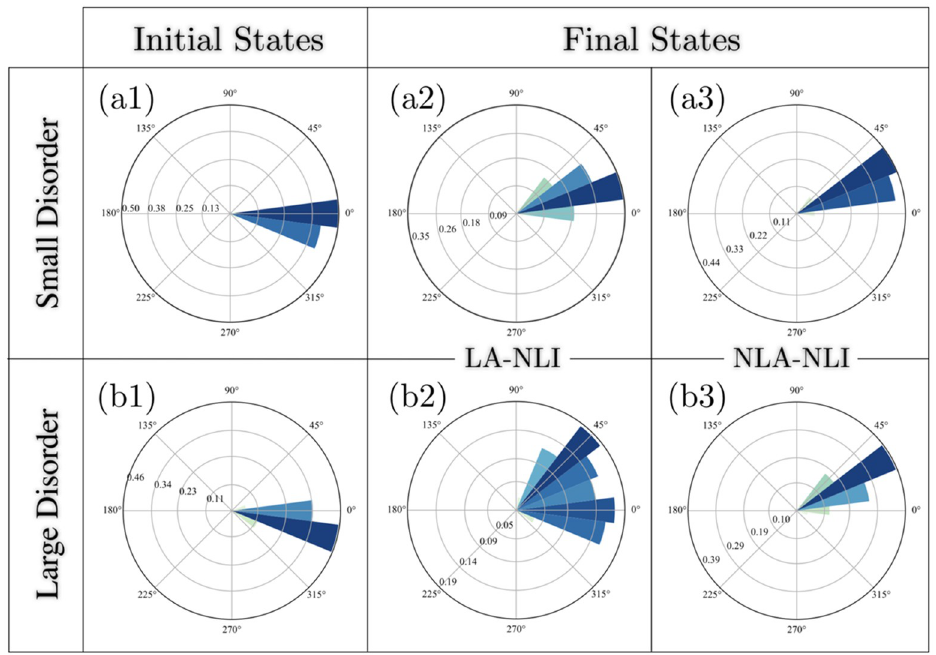
Fig 4. Comparison of the polarization stability in systems with local and nonlocal upregulating interactions, but identical cellular geometries and initial conditions (for each value of the geometric disorder). The magnitude of stochastic noise equals η 0 = 0.1 in all cases. (a1) illustrates a polarized initial condition in a tissue with small geometric disorder � 0 = 0.45. (a2) and (a3) show the steady-state angular distributions of dipoles in the same tissue with LA-NLI and NLA-NLI mechanisms, respectively. The same quantities are depicted in (b1), (b2) and (b3), but in tissue with large geometric disorder � 0 = 0.6. Loss of angular coherence in (b3), indicates that the absence of nonlocal upregulating interactions makes polarity susceptible to stochastic noises in disordered